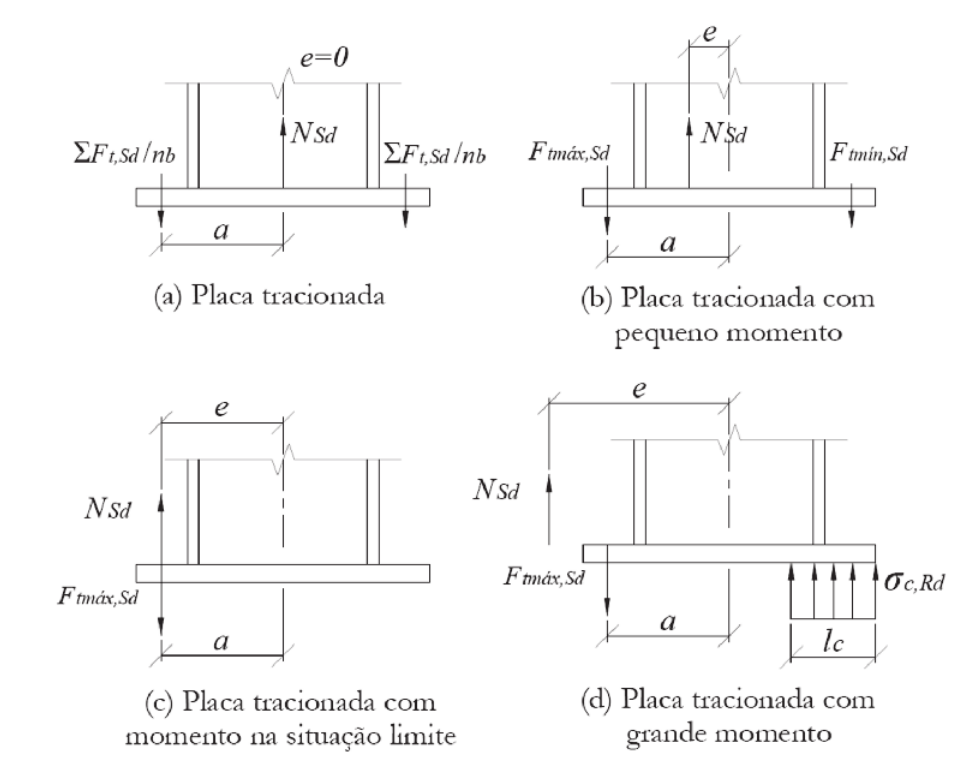
Figura 5 Comportamento de placas solicitadas por esforço axial de tração e momento fletor pela hipótese de distribuição uniforme de tensões de